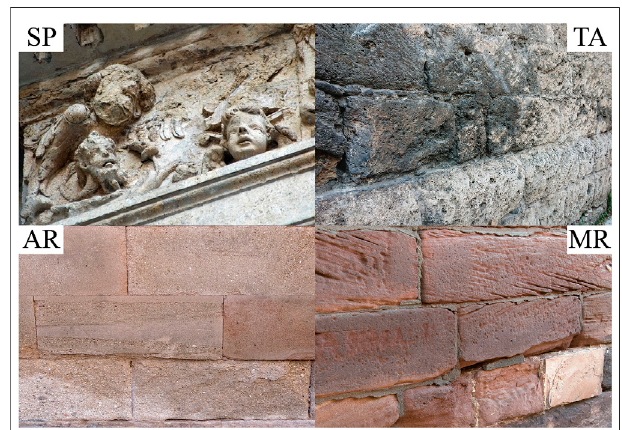
FIGURE 1 | Photographs showing some of the main deterioration phenomena, such as sanding, peeling, scaling, blistering, fl acking, differential erosioninCalcarenitadeSantaPudia(SP),AreniscaRonda(AR)andMolinaza Roja (MR), and microkarst, pitting and black crust in Travertino Amarillo